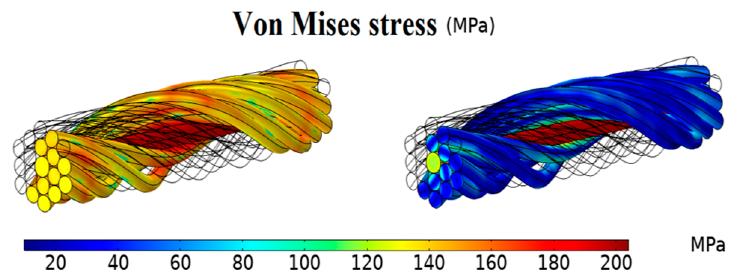
Figure 6. Distribution of the von Mises stress in the cable in MPa ( right in elastic range; left in plastic range).